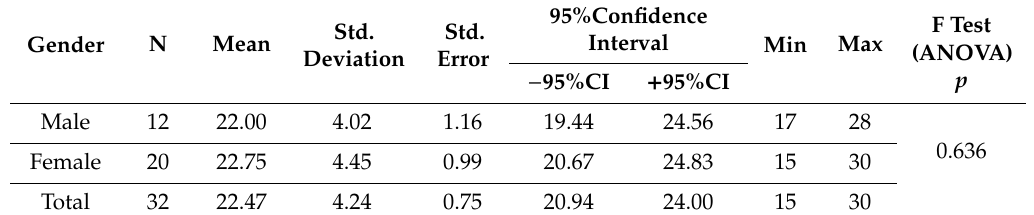
Table 3. Descriptive statistics of symptoms score by gender.